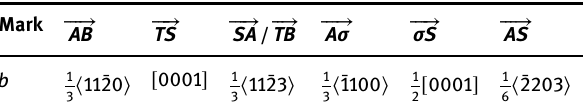
Table 1: Bergson marks of common dislocations in hexagonal close